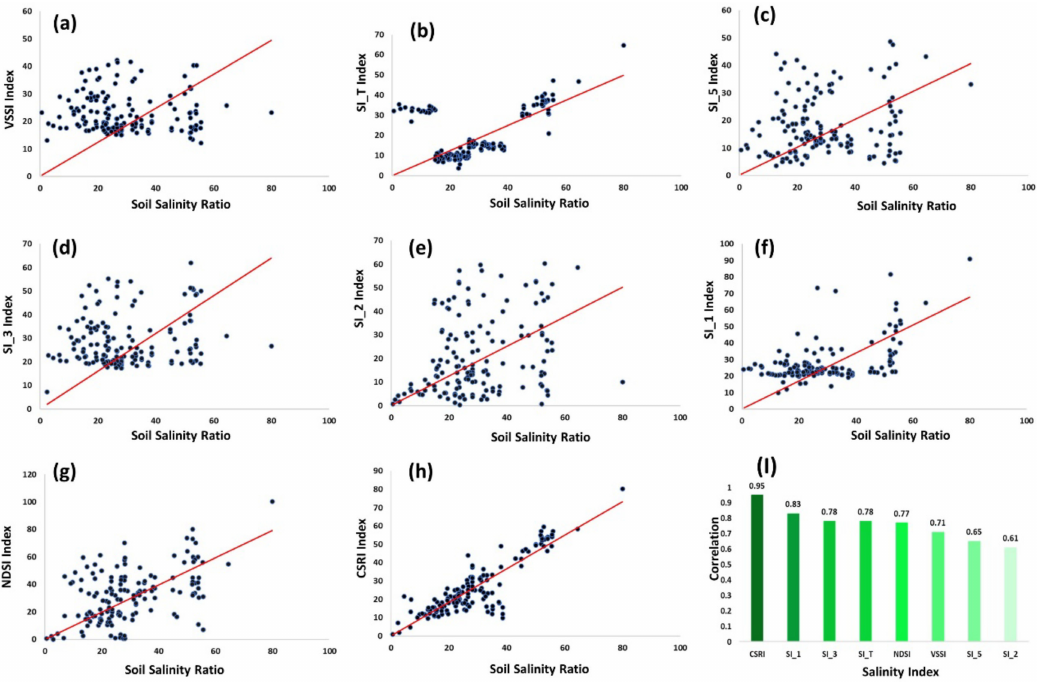
Figure 7. Validation results of the correlation between the soil salinity indices (see Figure 6) and the soil salinity data obtained in the laboratory for the ground control points (see Table 4). The computed correlations show the results for soil salinity indices: ( a ) VSSI; ( b ) SI_T; ( c ) SI_5; ( d ) SI_3; ( e ) SI_2; ( f ) SI_1; ( g ) NDSI; ( h ) CSRI; and ( I ) comparing the accuracy of all indices. The CSRI achieved the highest accuracy.